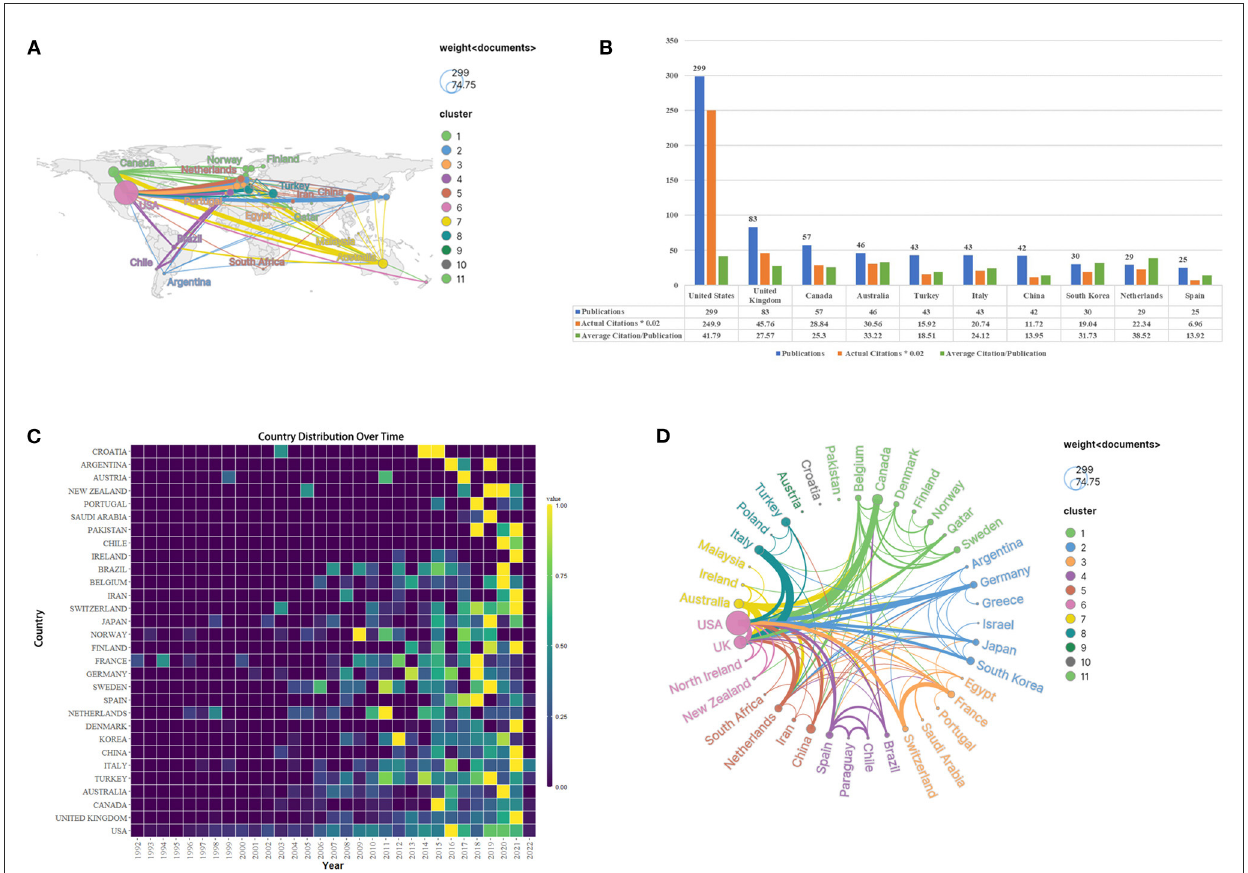
FIGURE3 The information on contributive countries of the rehabilitation of rotator cuff injury. (A) The geographical visualized map of countries. (B) The number of publications, total citations and citations per year in the top 10 countries. (C) The heatmap of country distribution over time from 1992 to 2022. (D) The cooperative network visualized map of countries.